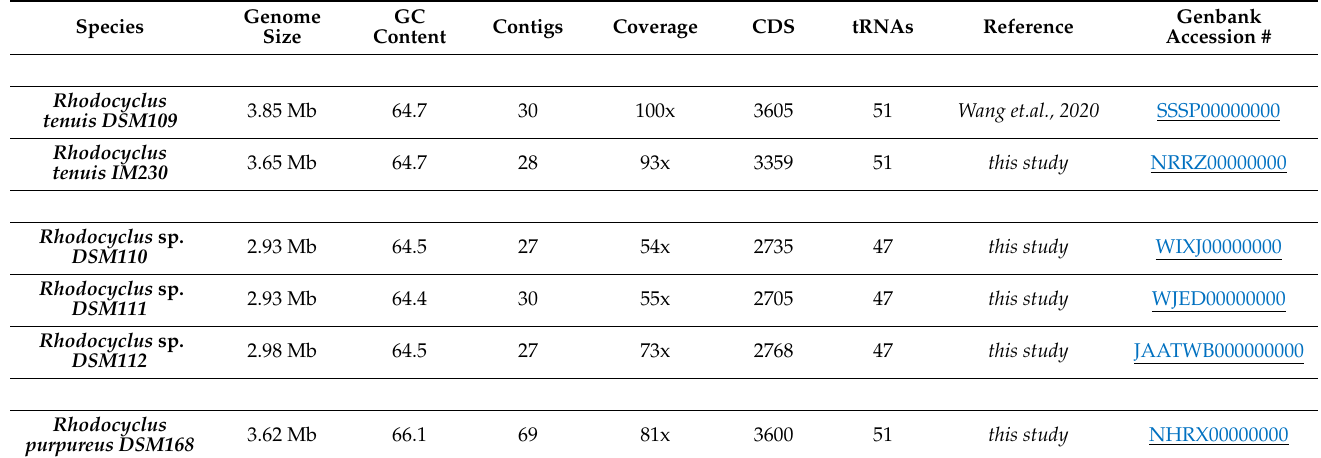
Table 1. Overview of genome features of all of the Rhodocyclus genome sequences.